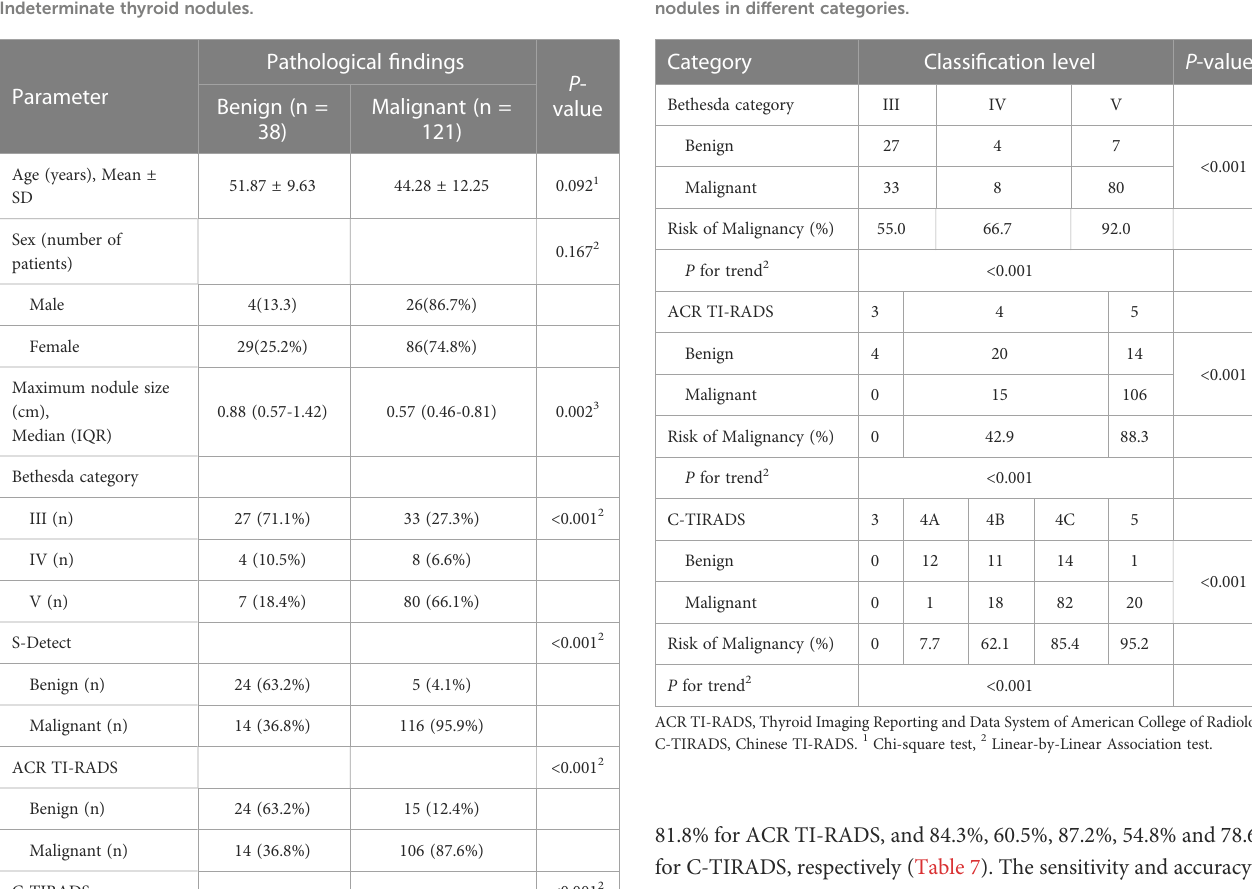
TABLE 4 Clinicopathological characteristics of the cytologically Indeterminate thyroid nodules.